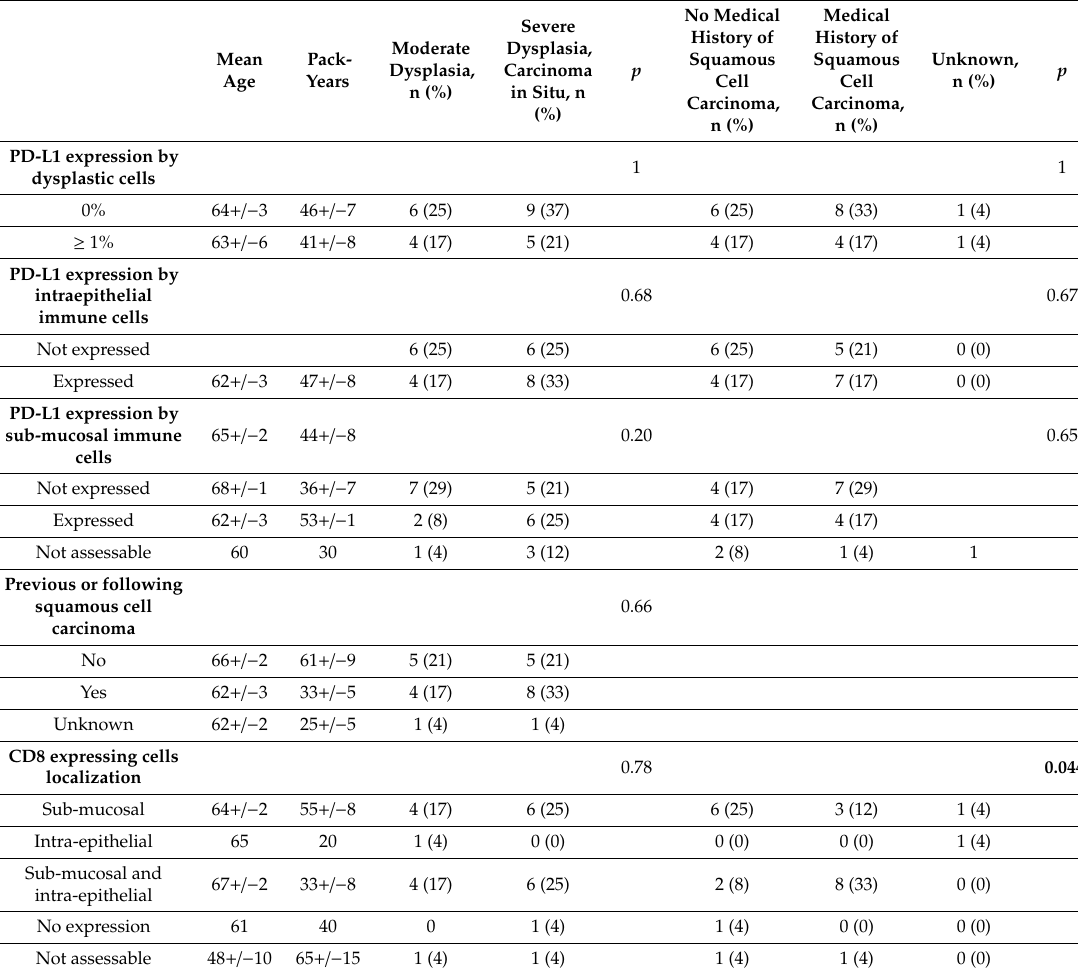
Table 2. Relationship between dysplasia groups, medical history of squamous cell carcinoma and PD-L1, and